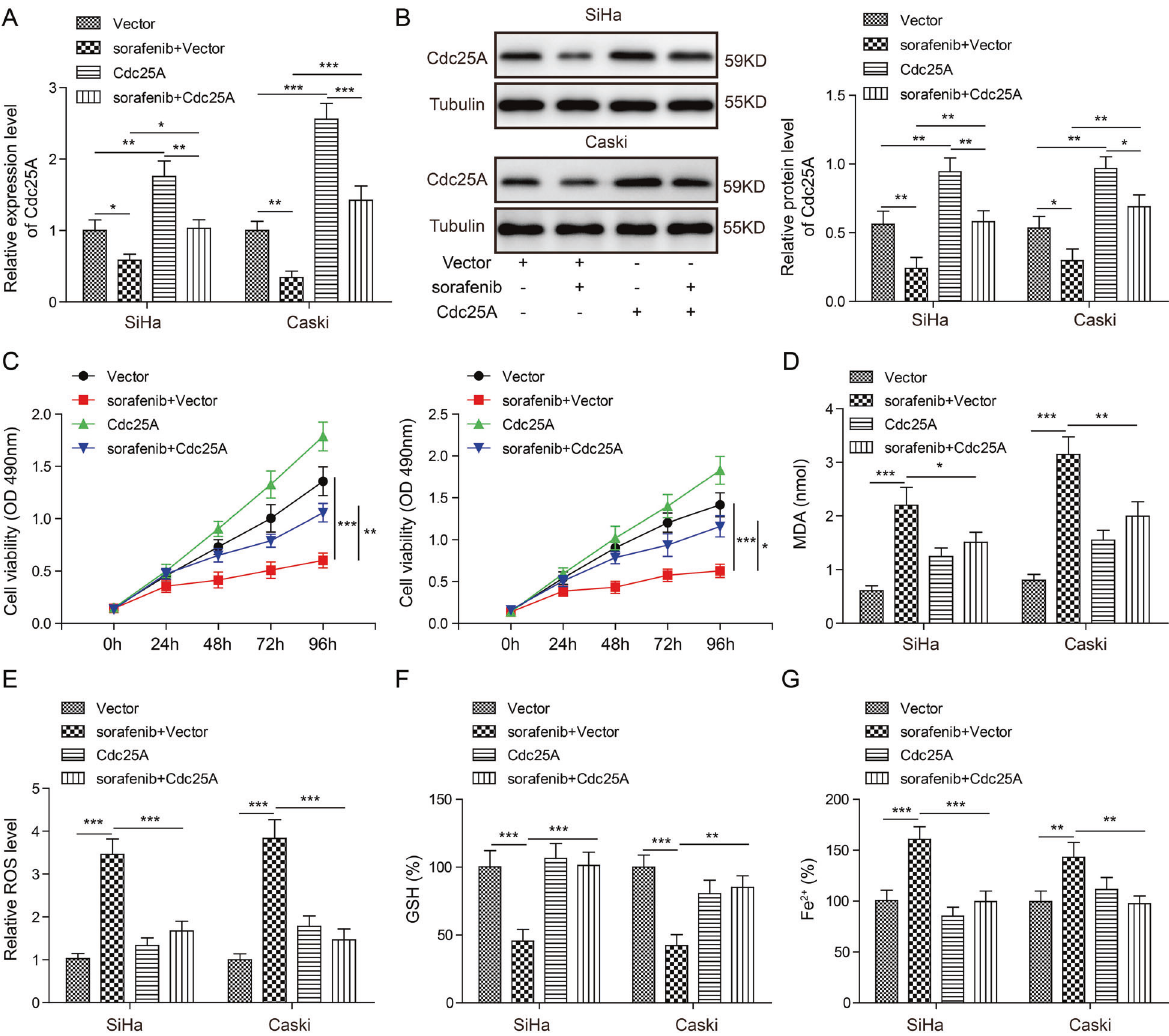
Fig. 3 Overexpression of Cdc25A suppressed sorafenib-induced ferroptosis. A Relative Cdc25A mRNA levels in transfected cells with or without sorafenib treatment. B Relative Cdc25A protein levels in transfected cells with or without sorafenib treatment. C The MTT assay to analyse the viability of transfected cells following sorafenib treatment. D Cellular MDA levels in transfected cells after sorafenib treatment. E Cellular ROS levels in transfected cells after sorafenib treatment. F Cellular GSH levels in transfected cells after sorafenib treatment. G Cellular iron levels in transfected cells after sorafenib treatment. Each experiment was repeated three times. * P < 0.05; ** P < 0.01; *** P <